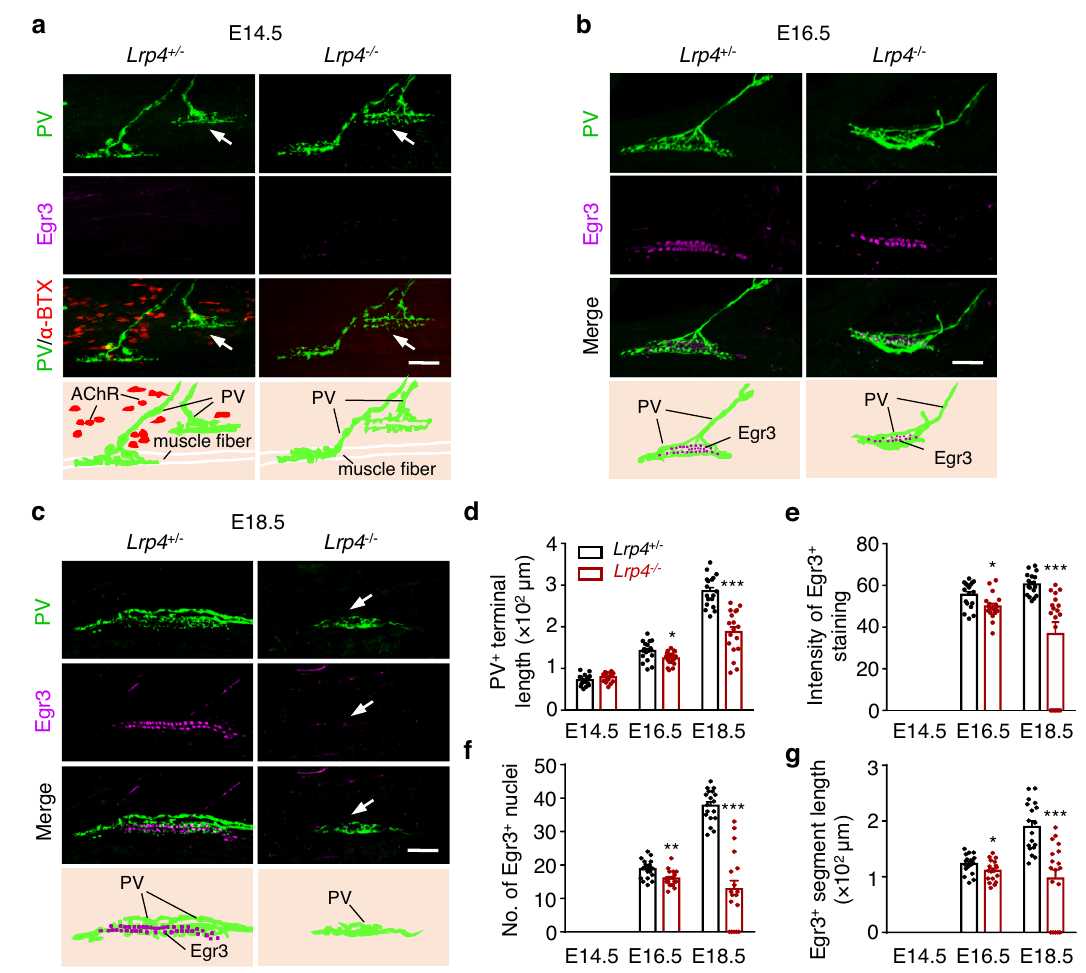
Fig. 3|ReducedEgr3levelsin Lrp4 mutant mice.a The inductionof preliminary muscle spindle in Lrp4 mutant. Shown were TA muscles at E14.5 in indicated genotypes, whole-mount stained with PV (green), α -BTX (red), and Egr3 (magenta). Arrows, preliminary muscle spindle was induced and innervated by PV + sensory axons. Scale bar, 50 µ m. b , c Reduced innervation and Egr3 expres- sion in Lrp4 mutant. Represent images of muscle spindle in TA whole mount stained with PV and Egr3 at E16.5 ( b ) or E18.5 ( c ). Arrows, spindle without Egr3 expression.Scalebar,50 µ m. d – g Quanti fi cationofdatain( a – c ). d Quanti fi cation